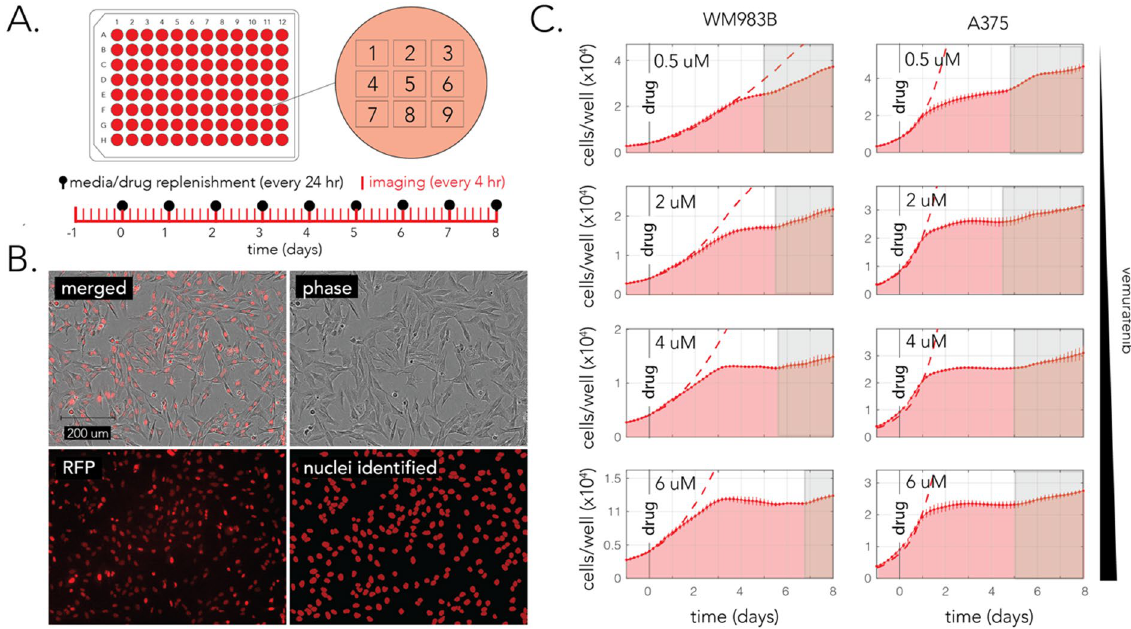
Figure 2. Transient growth arrest after vemurafenib treatment in bulk populations. ( A ) A diagram of the drug treatment and imaging protocol. Cells were plated in a 96-well microplate and drug was replenished every 24 h. Each well was imaged with nine non-overlapping imaging fields and treatments were applied in duplicates. ( B ) Representative microscopy images and the paired image analysis for counting nuclei number in each imaging field. ( C ) Changes in cell number over 8 days of drug treatment across multiple drug concentrations. The red area shows the inferred number of cells (per well) in drug treated wells (the bars show the standard deviation across biological replicates). The dashed red line shows the number of cells in a control (no-drug) experiment. The gray area shows the period with notable growth recovery (determined by eye). We observed growth recovery in both cell-lines, across all drug